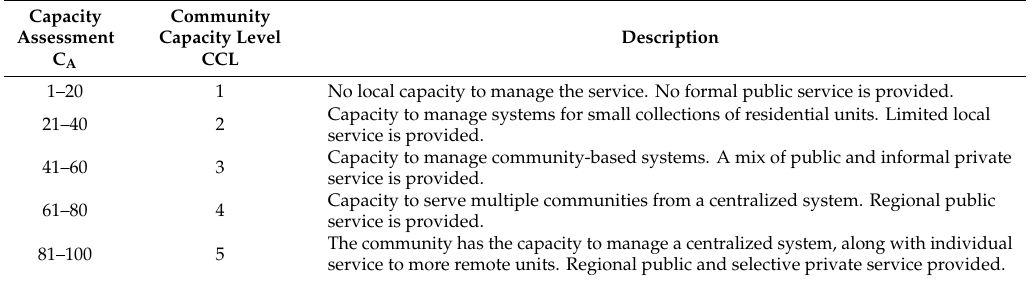
Table 2. Community capacity levels (adapted from [15] and